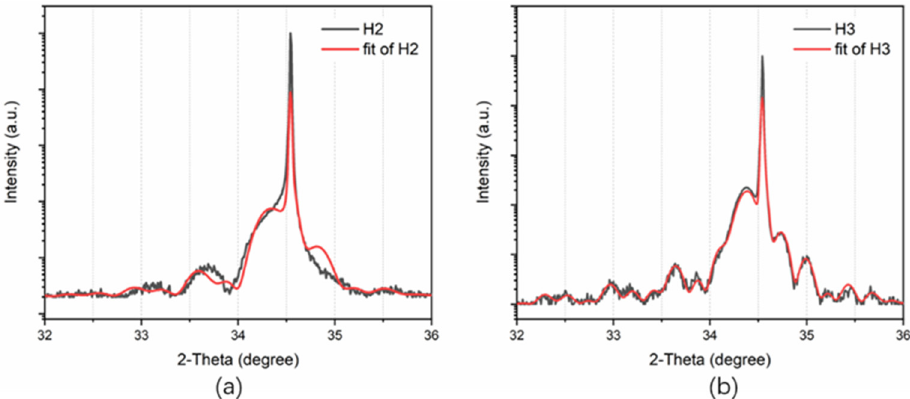
Figure 5. High resolution X-ray diffraction (HRXRD) ω -2 θ scanning curves on (0002) of ( a ) sample H2 and ( b ) sample H3. The black and red lines are the measurement data and fitting data, respectively.